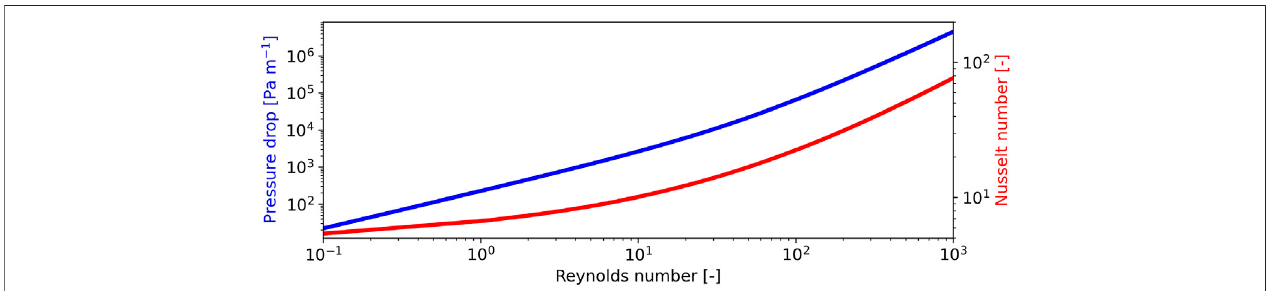
FIGURE 1 | Dependence of pressure drop and heat transfer on the Reynolds number for a packed bed of spheres. Values calculated using the Ergun equation for pressuredropandtheGunncorrelationforheattransfer,usingthephysicalpropertiesofnitrogen,abedporosityof40%andaparticlesizeof1 mm(Ergun,1952;Gunn, 1978).